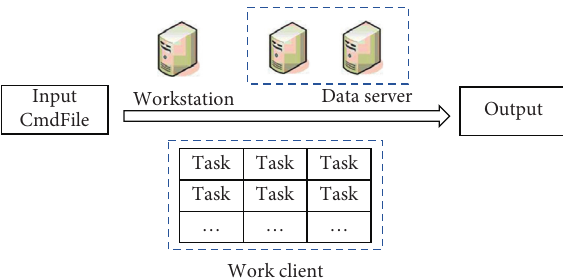
Figure 4: Video processing architecture.